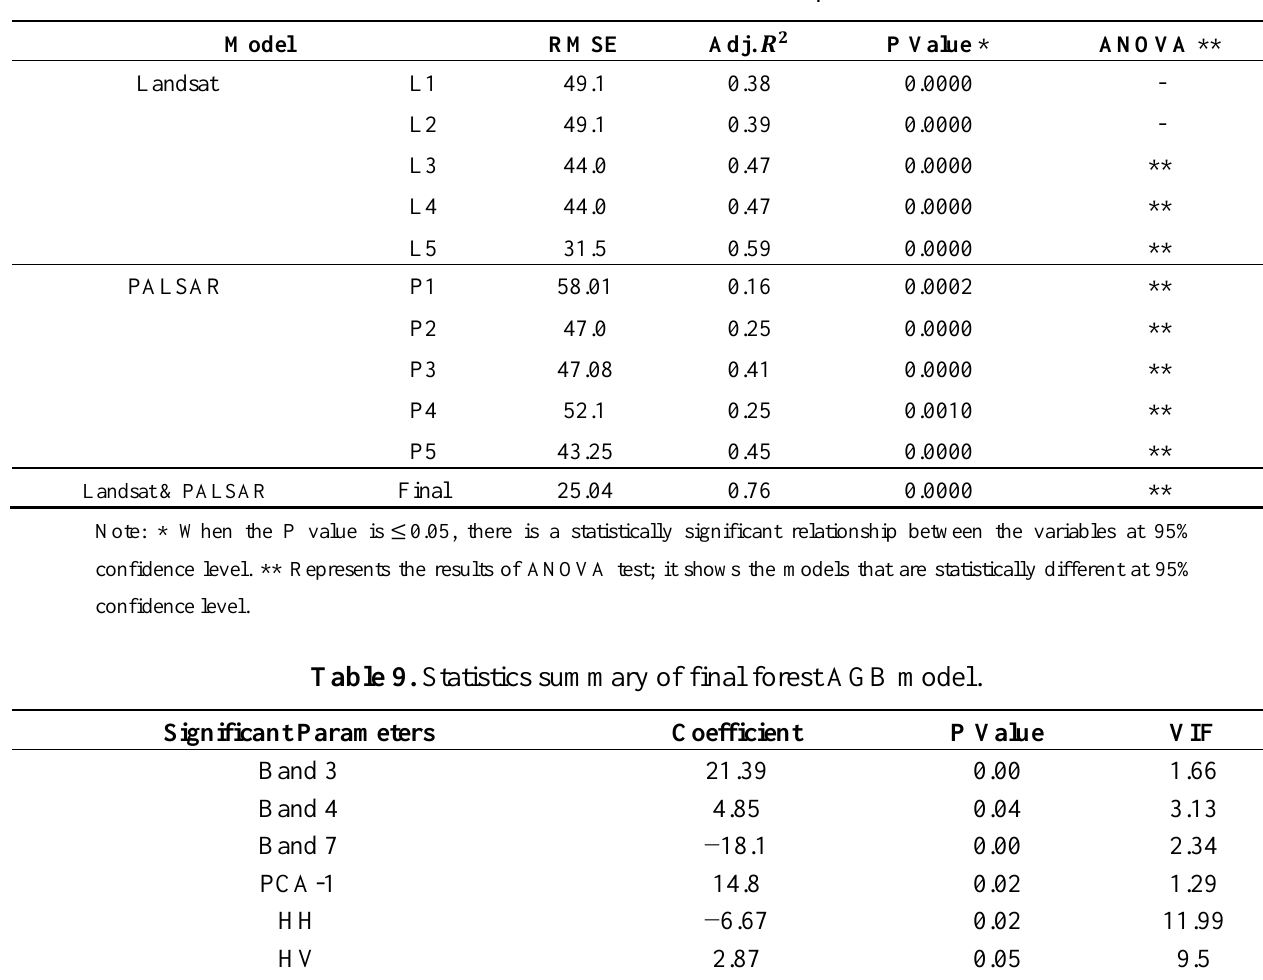
Table 8. Forest AGB estimation model parameters.